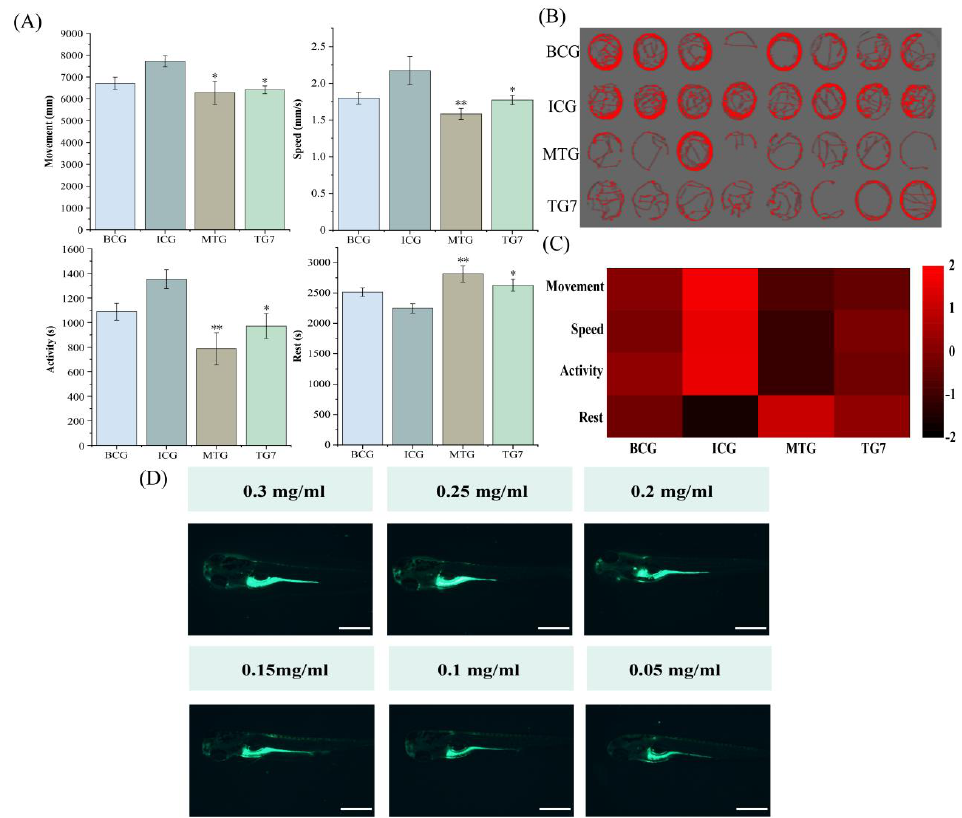
Figure 4. ( A ) Effect of TG7 (0.2 mg/mL) on behavioral indicators of zebrafish; ( B ) zebrafish behavior trajectory map; ( C ) behavioral fingerprinting; ( D ) distribution and fluorescence intensity of TG7-Acp-FITC in zebrafish. Scale bars: 500 µm. The p -values for each group were calculated by comparison with the ICG. Blank control group (BCG), normal growth of zebrafish without adding any drugs; Insomnia control group (ICG); Positive drug (melatonin) group (MTG); Tyr-Gly-Asn-Pro-Trp-Glu-Lys (TG7). Data are expressed as mean ± SD. (Student t-test, * p < 0.05, ** p < 0.01, n = 8).